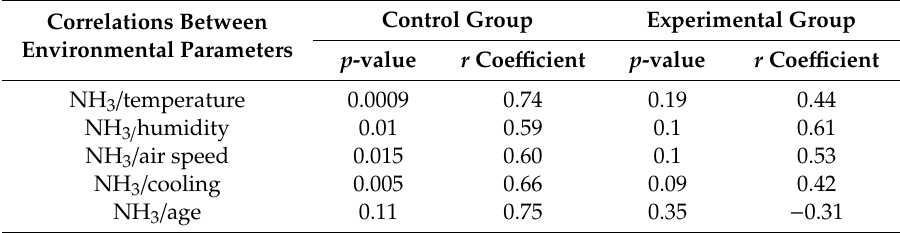
Table 2. Pearson’s correlation coe ffi cient between NH 3 concentration in air and microclimate parameters in turkey houses ( r